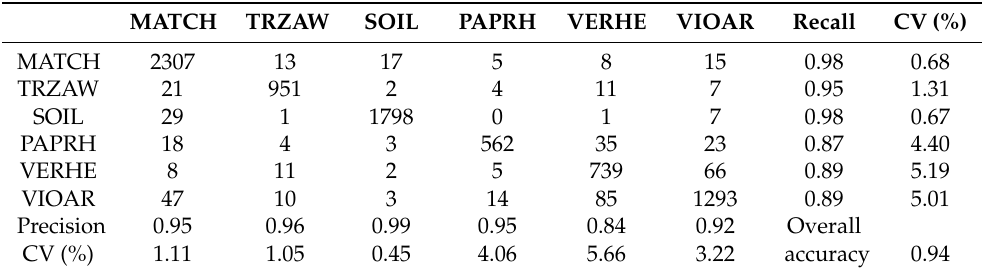
Table 3. Confusion matrix for the evaluation on the test set for the image-level classifier using the ResNet-18 model with filter configuration 10(20). The resulting counts were agglomerated from five random seeds by median. CV refers to the coefficient of variation computed from the different outcomes of recall or precision expressed in percentage.